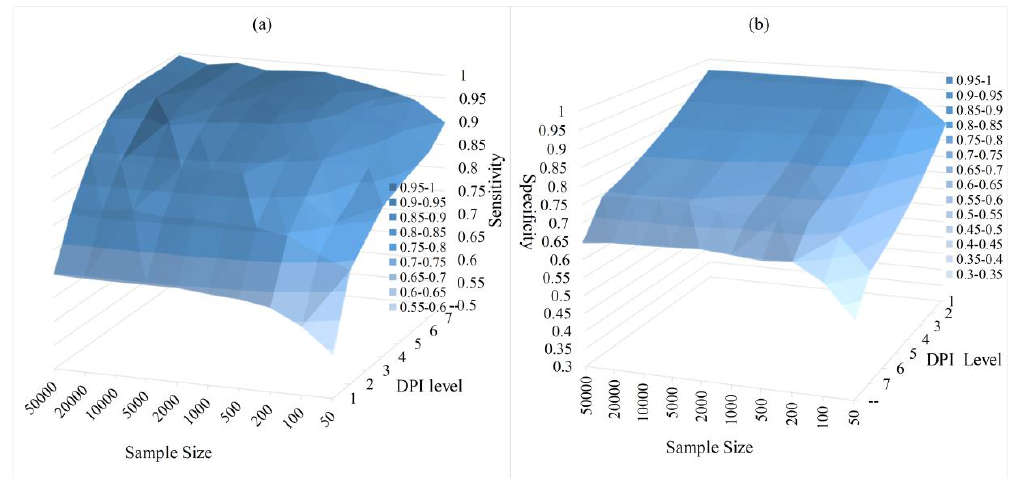
Figure 4. The neighbor selection results with different sample sizes and different DPI Levels. ( a ) sensitivity result in the alarm network; ( b ) specificity result in the alarm network. ‘–’ denotes no pruning.